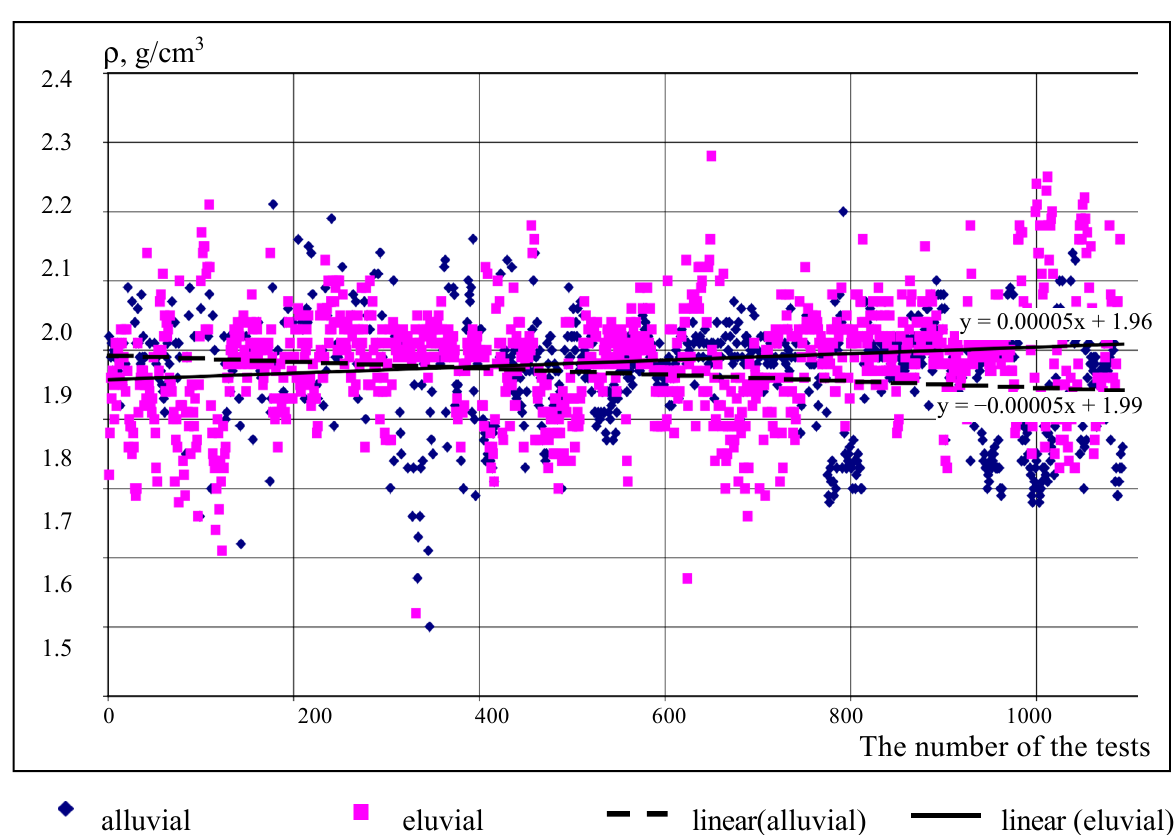
Figure 5. Scatter plot of the bulk density for alluvial and eluvial clay